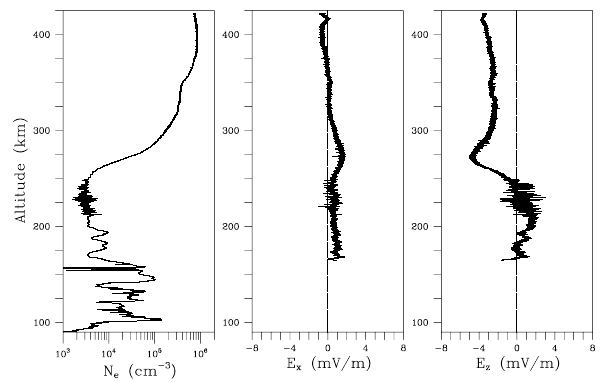
Fig. 6. Upleg data from the 7 August rocket flight. Left panel: electron density. Center panel: zonal electric field. Right panel: vertical electric field.